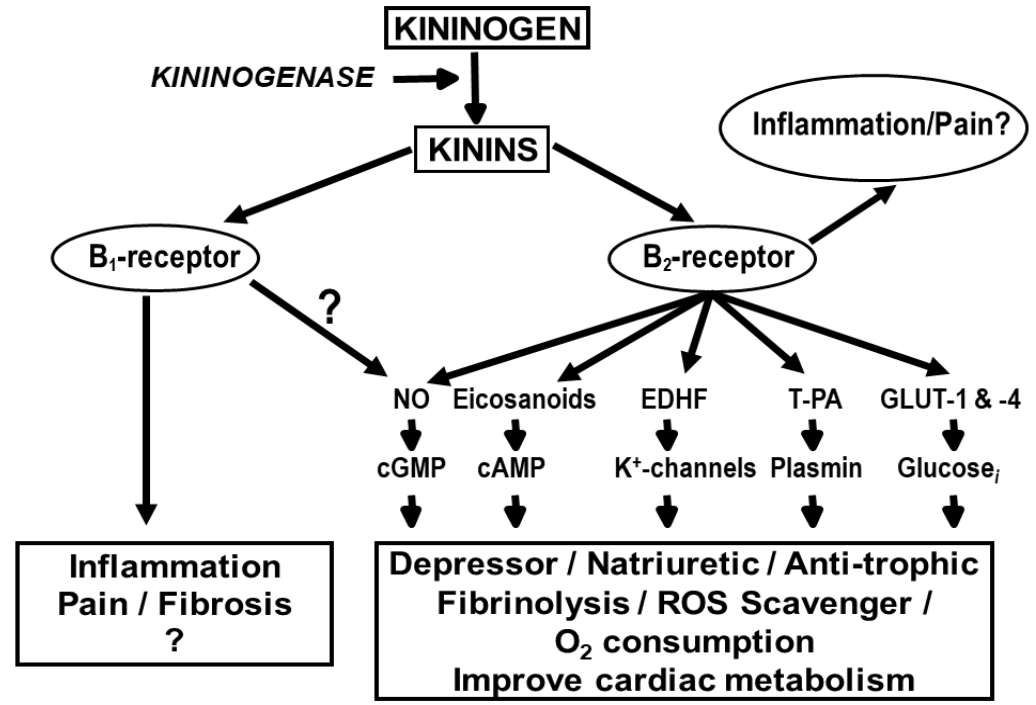
Figure 2. Kinins act via the B 2 and B 1 receptors. Most of the known effects of kinins are mediated by the B 2 receptor which in terms act by stimulating the release of various intermediaries: eicosanoids, endothelium-derived hyperpolarizing factor (EDHF), nitric oxide (NO), tissue plasminogen activator (T-PA), glucose transporter (GLU-1 and -2) (modified from Rhaleb et al. [2])